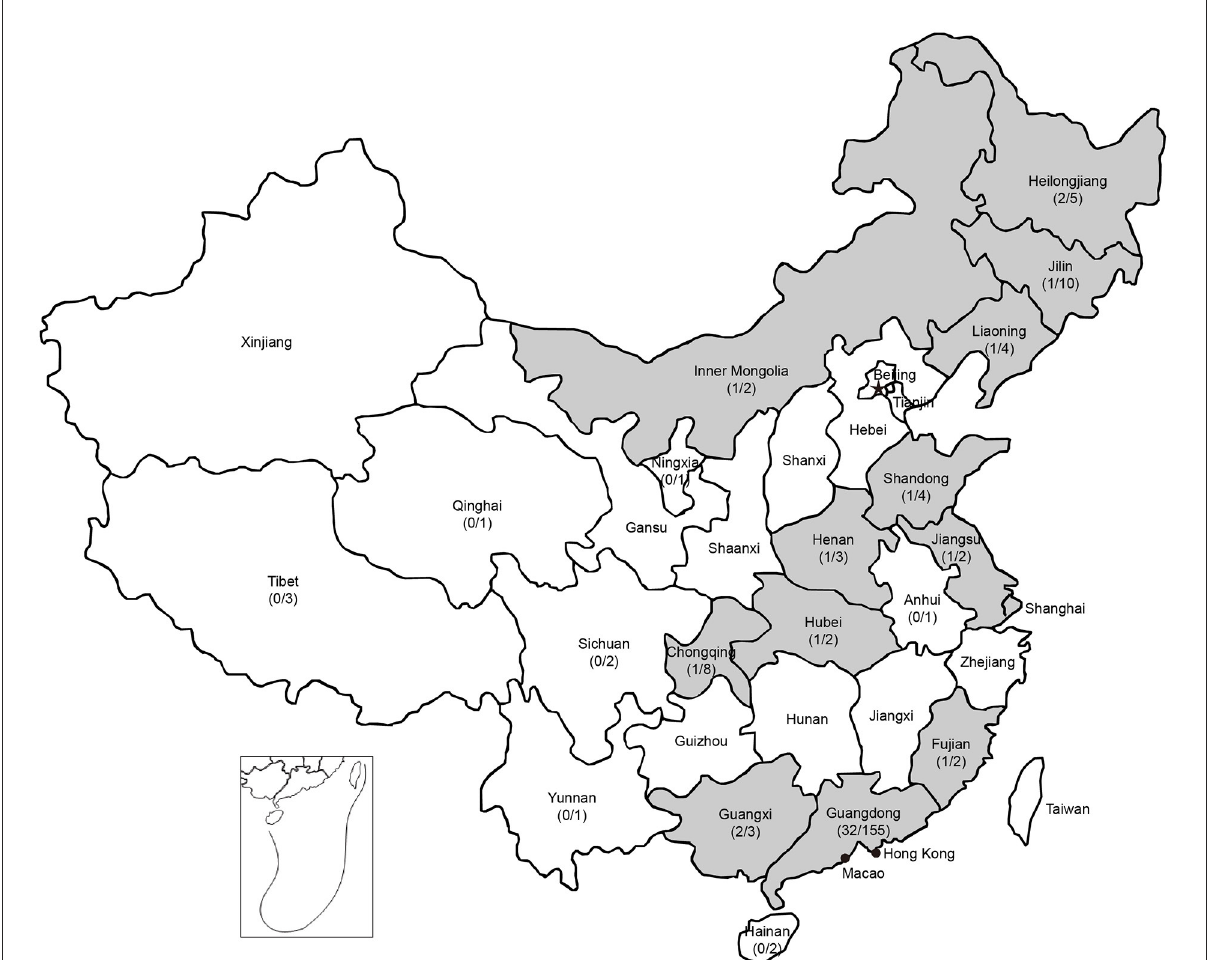
FIGURE3 Geographic distribution of PPV8 positive samples in China. Positive rates of PPV8 infection within sampled regions are listed in parentheses. Gray background indicated the PPV8 positive